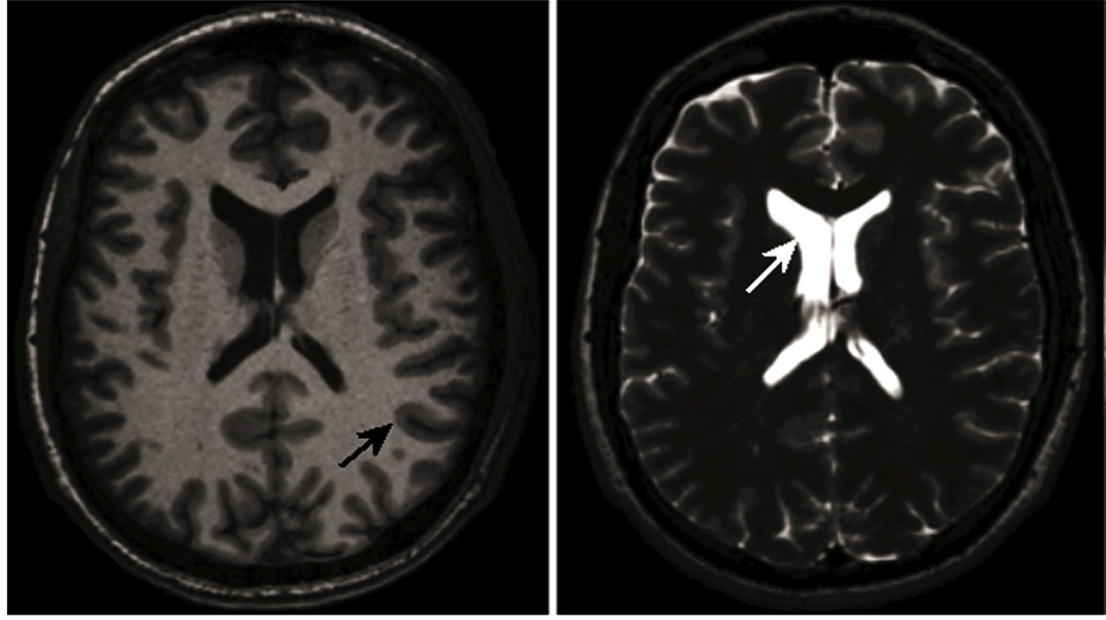
Figure 1. Comparison of T transverse slice through the brain (left). As can be seen T excellent contrast between gray and white matter (black arrow) as well as a good definition of the ventricles. On the right side the same slice with T the lower gray and white matter contrast but the excellent definition of the ventricles (white